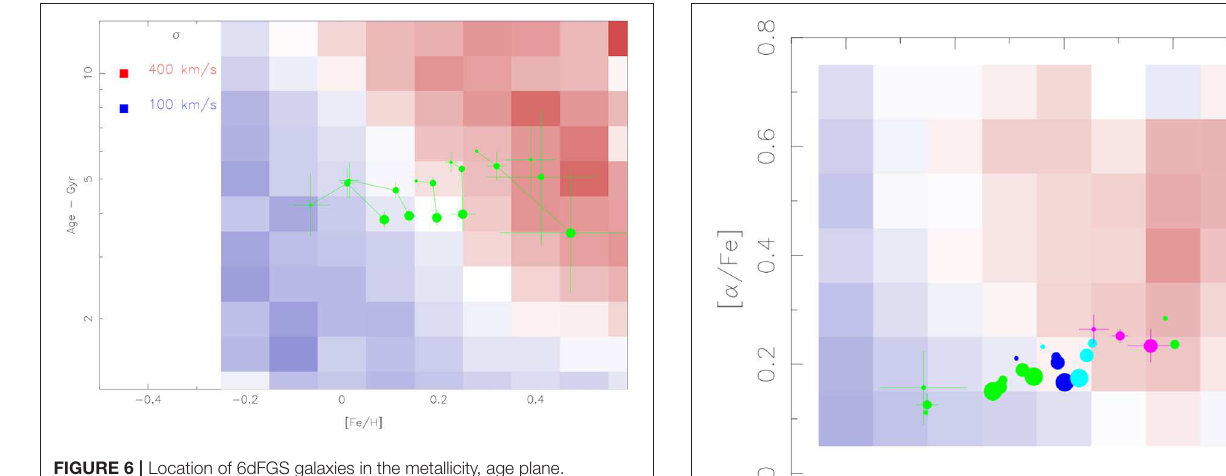
FIGURE 6 | Location of 6dFGS galaxies in the metallicity, age plane. Properties are color coded by velocity dispersion with giant (red) galaxies old and metal rich and lesser (blue) galaxies younger and metal poorer. Galaxies which are low surface brightness relative to the mean for their σ and r e on the FP are small green symbols; high SB galaxies are large green symbols. Green lines connect bins characterized by their range in σ . An upward vertical green line would be a stellar population fading at constant metallicity.